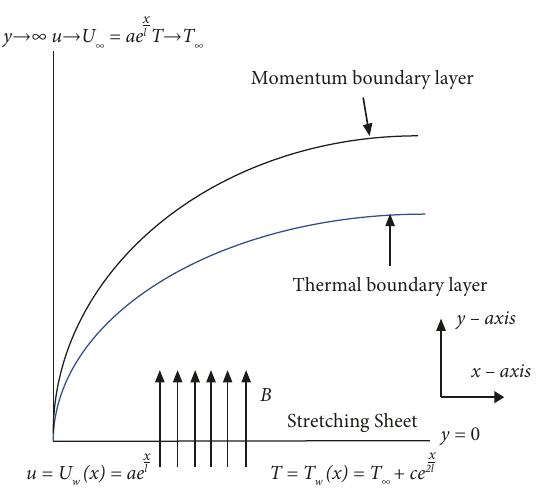
Figure 1: Interpretation of momentum and thermal boundary